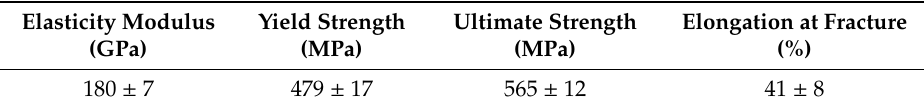
Figure 2. The test specimens with dimensions: a — as-built cylinder; b — a specimen for static and conventional fatigue tests; c — a specimen for VHCF tests. All dimensions shown are in millimeters. Table 2. Tensile properties of the L-PBF 316L